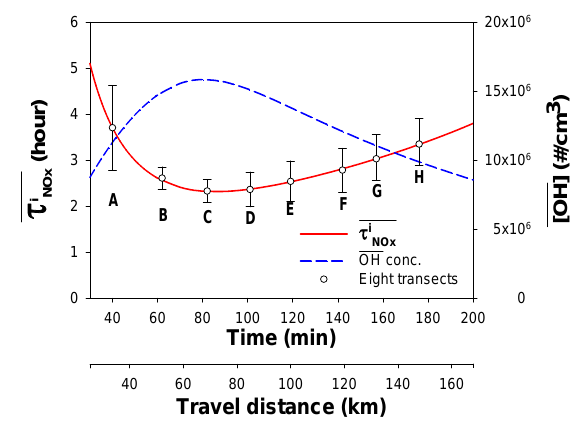
h i τ i along the ship-plume travel NO x